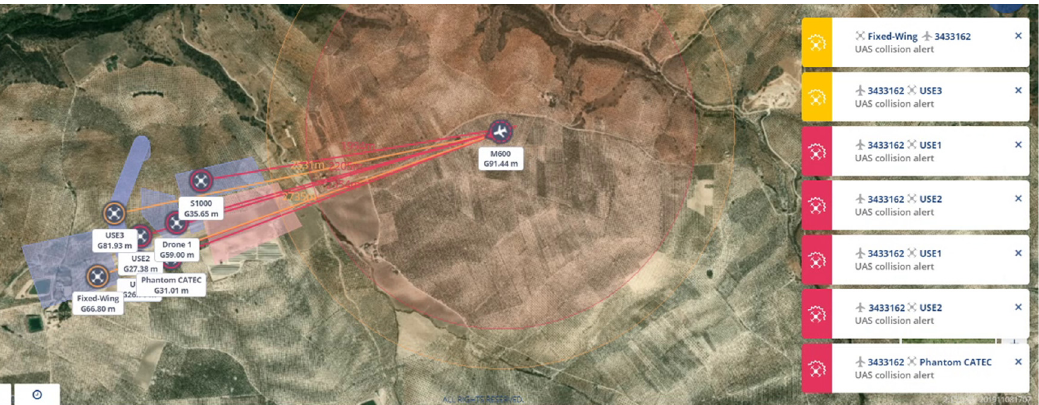
Figure 13. Seven drones flying simultaneously with a general aircraft in VLL in an emergency situation.